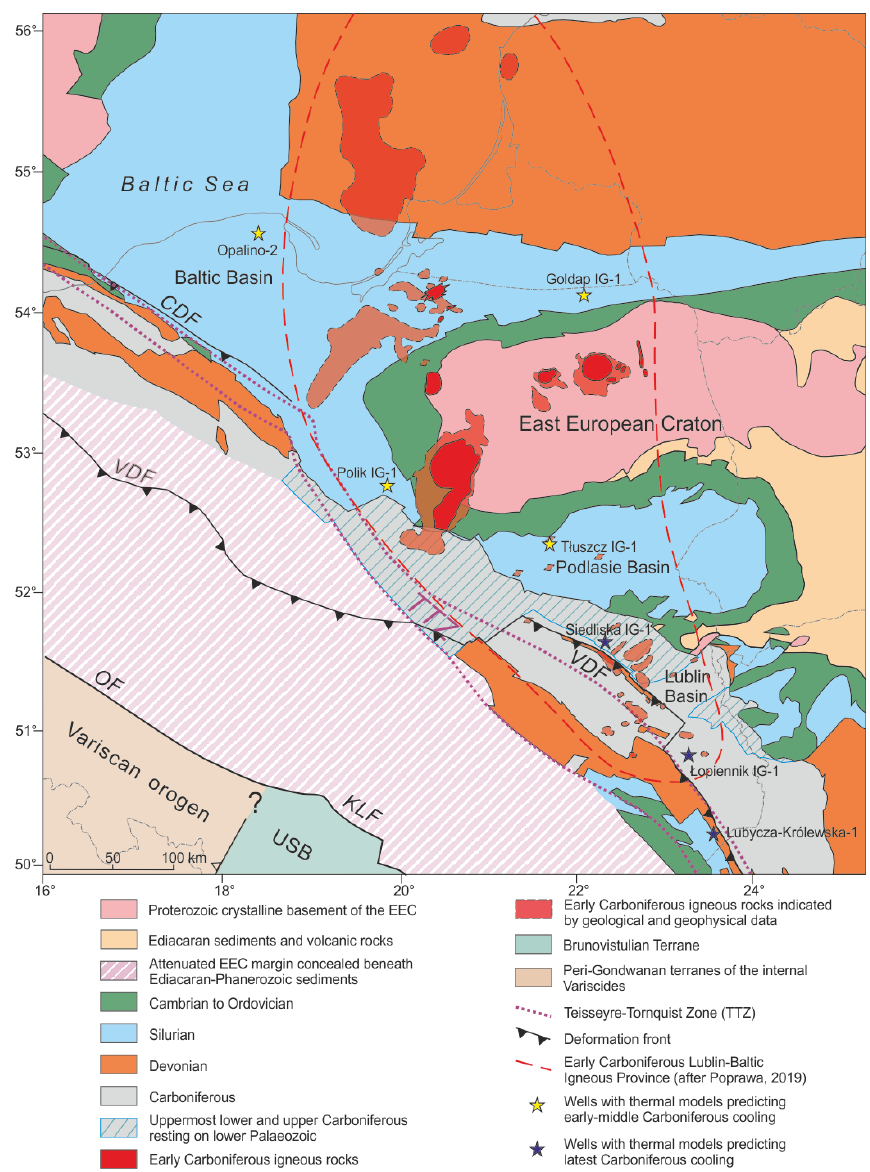
Figure 14. Pre-Permian geology map for the SW slope of the East European Platform in Poland and adjacent areas (partly based on Po˙zaryski and Dembowski, 1983). The extent of early Carboniferous igneous rocks and the Lublin–Baltic Igneous Province is shown after Poprawa (2019). Location of the Variscan Deformation Front is from Mazur et al. (2021). Further explanations are in the text. CDF – Caledonian Deformation Front; KLF – Kraków–Lubliniec Fault; OF – Odra Fault; TTZ – Teisseyre–Tornquist Zone; USB – Upper Silesia Block; VDF – Variscan Deformation